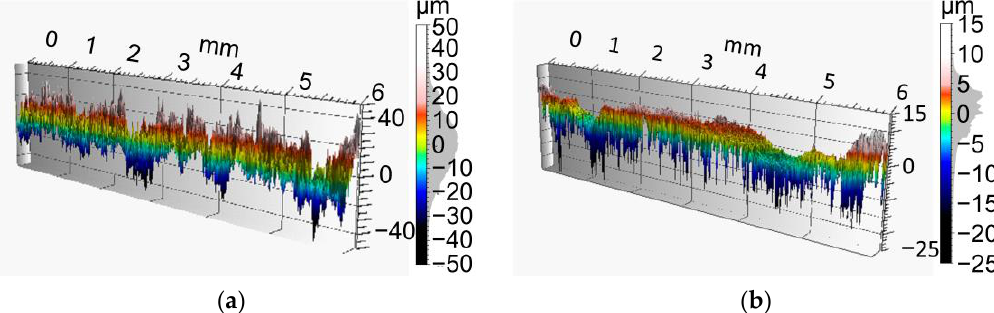
Figure 9. Surface profiles of coating systems: ( a ) ZnAl-coated (II) specimen, ( b ) machine hammer-